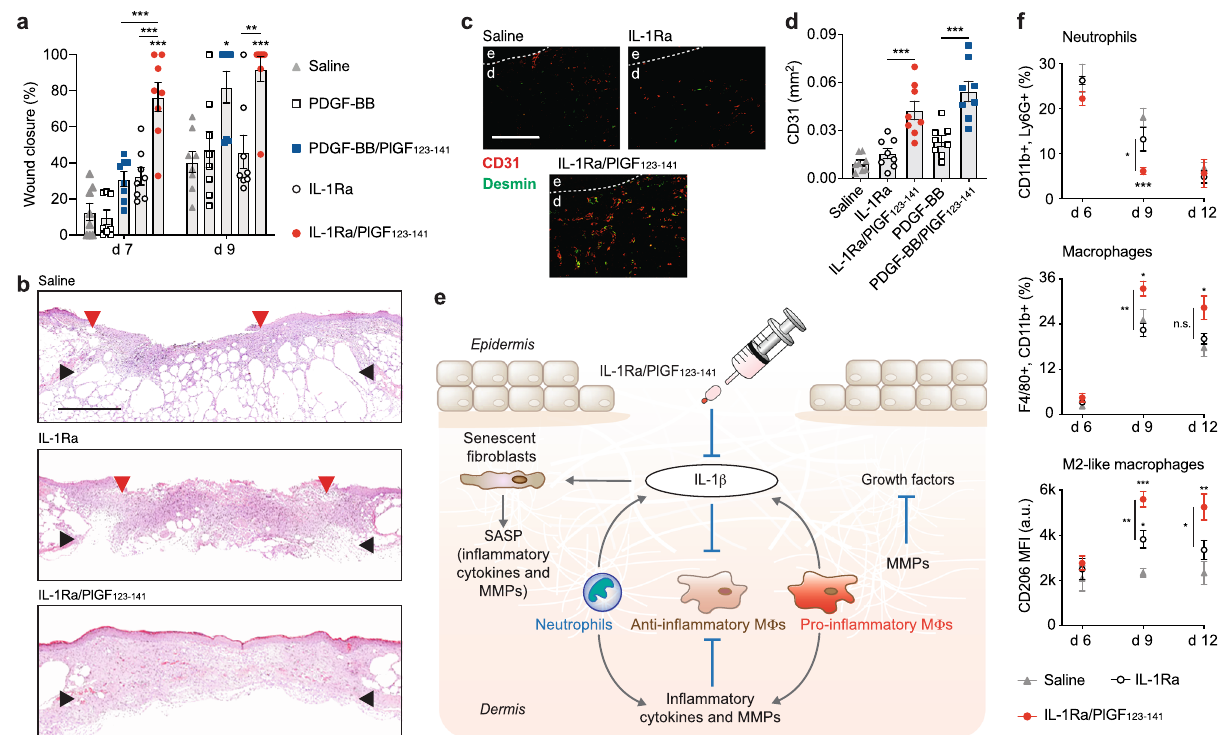
Fig. 3 Super-af fi nity IL-1Ra accelerates wound healing in diabetic mice. a , b Full-thickness wounds in Lepr db/db were treated with IL-1Ra or PDGF-BB variants (0.5 μ g of wild types, equimolar of engineered versions). Wound closure evaluated by histomorphometric analysis of tissue sections in ( a ). n = 8 wounds per condition. Representative histology (haematoxylin and eosin staining) 9 days post treatment shown in ( b ). Black arrows indicate wound edges and red arrows indicate tips of epithelium tongue. The epithelium (if any) appears in purple as a homogeneous keratinocyte layer on top of the wounds. The granulation tissue under the epithelium contains granulocytes with dark-purple nuclei. Fat tissue appears as transparent bubbles. Scale bar = 1 mm. c , d Angiogenesis at day 9 assessed by immunostaining of wound sections for CD31 (endothelial cells, red) and desmin (smooth muscle cells, green). Representative images in ( c ). Dashed lines indicate separation between epidermis (indicated as e ) and dermis (indicated as d ). Scale bar = 0.2 mm. Quanti fi cation of CD31 in ( d ). n = 8. e Schematic representation of hypothesised IL-1Ra/PlGF 123 – 141 effects in diabetic wounds. M Φ s macrophages, MMPs matrix metallopeptidases, SASP senescence-associated secretory phenotype; grey arrows represent induction; blue lines represent inhibition. f Neutrophil and macrophage populations in wounds measured by fl ow cytometry at various time points post wounding. Percentages were calculated over total live wound cells. Median fl uorescence intensity (MFI) for CD206 was measured in macrophages (F4/80 + , CD11b + cells). n = 8 wounds. In ( a ), ( d ) and ( f ), data are means ± SEM. One-way ANOVA with Bonferroni post hoc test for pair-wise comparisons (signi fi cances shown are between saline and the other groups, unless indicated otherwise). * P ≤ 0.05, ** P ≤ 0.001, *** P ≤ 0.001. ns non-signi fi